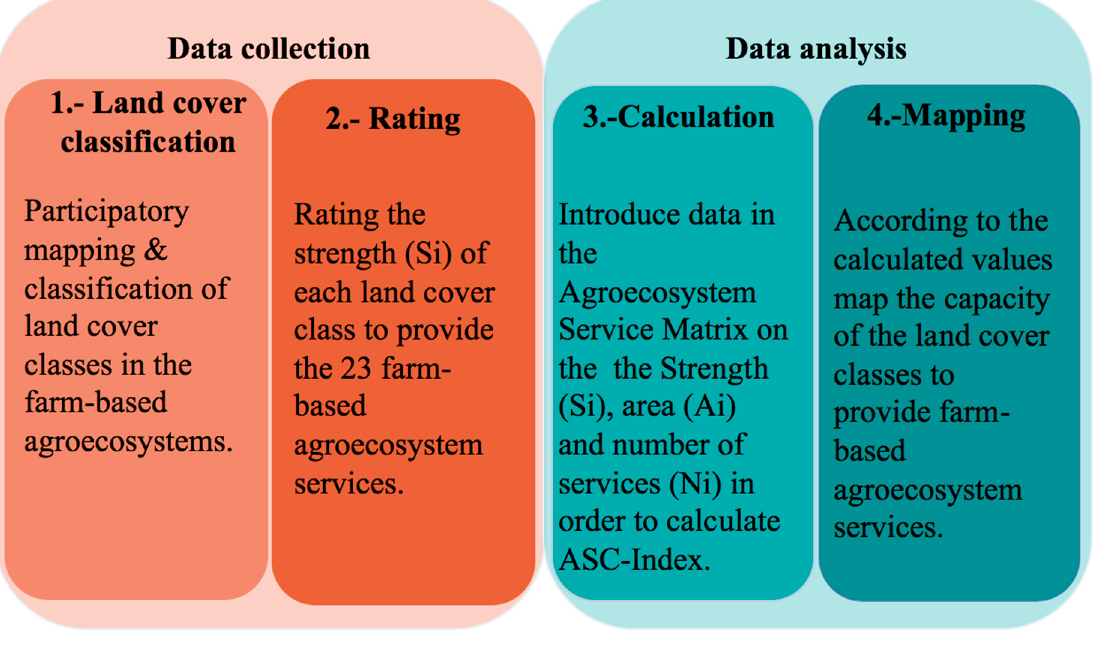
Figure 4. The agroecosystem capacity index in nutshell based on Augstburger, and Rist [26] .